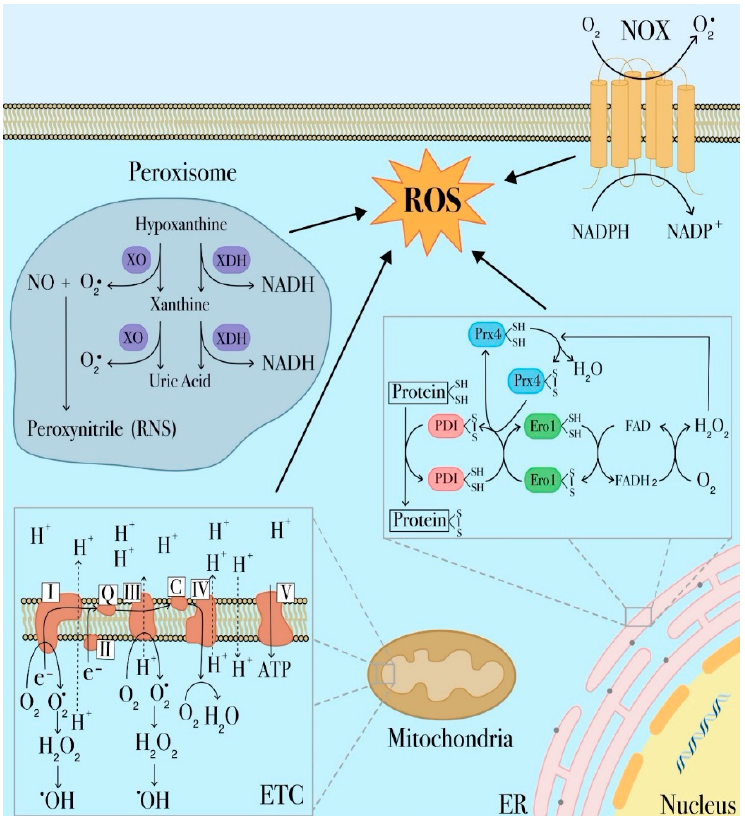
Figure 1. Major sites of reactive oxygen species (ROS) production in leukemia cells. ROS are derived from different cellular compartments and enzymatic systems. The most significant source of ROS in the cell is represented by mitochondria, in which ROS are largely generated by the electron transport chain (ETC). Other ROS-producing mechanisms involve transmembrane NADPH oxidases (NOX), xanthine oxidoreductase in peroxisomes and protein disulfide isomerase (PDI) in endoplasmic reticulum